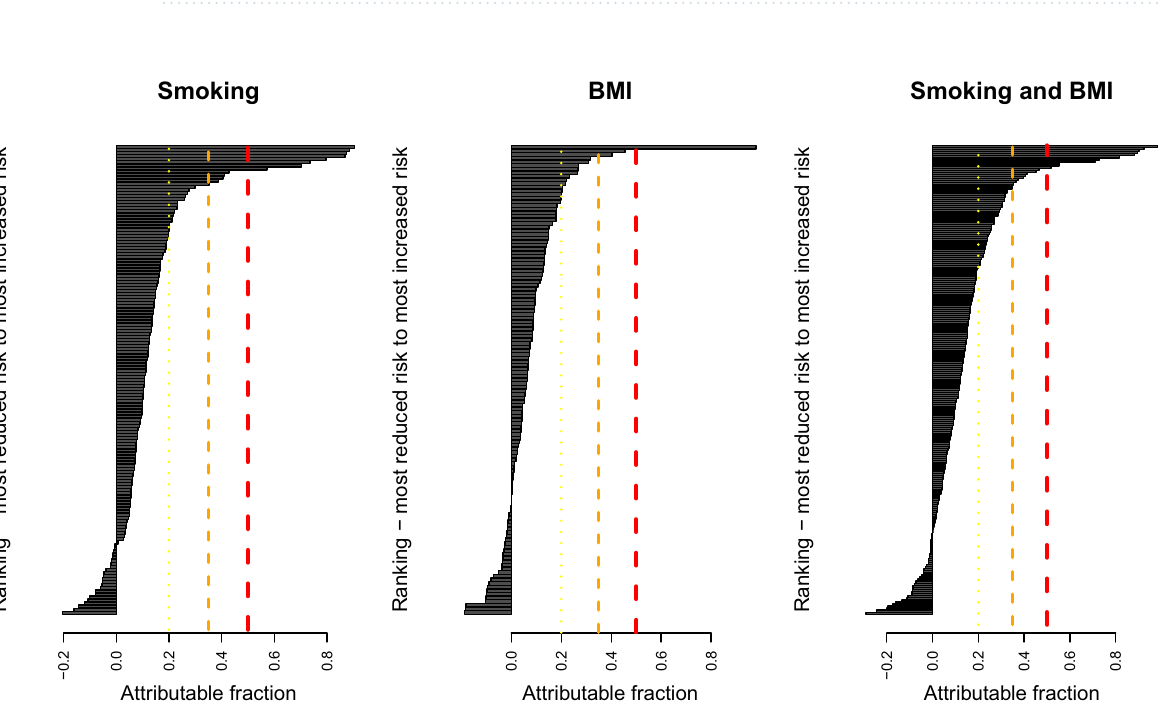
Figure 3. For diseases with a statistically significant association with smoking or BMI after an FDR multiple- testing adjustment, attributable fractions A f were calculated with Eq. (10). Lines indicate A f = 0.5 (red), A f = 0.35 (orange), A f = 0.2 (yellow). A f < 0 indicates a protective